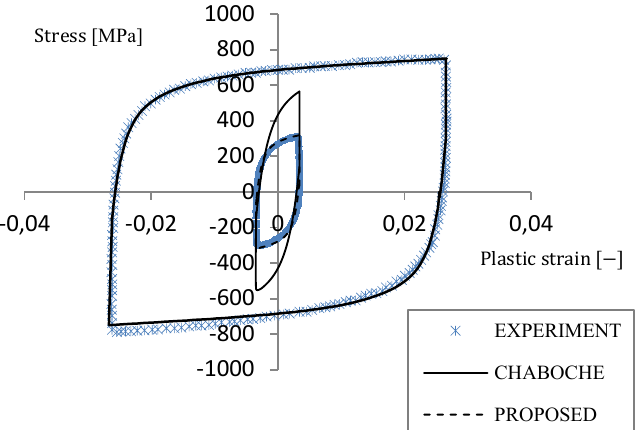
Figure 2. Prediction of two uniaxial hysteresis loops of SS304 (experimental data were taken from